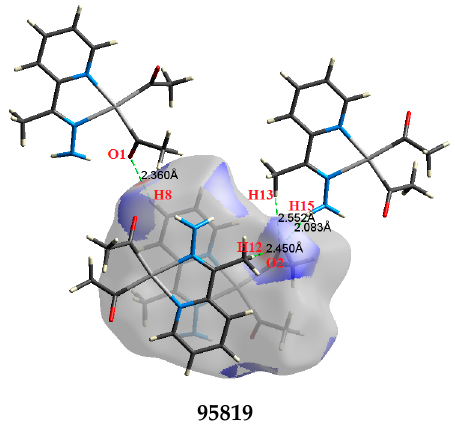
Figure 3. The most important intermolecular contacts in complex 1 .